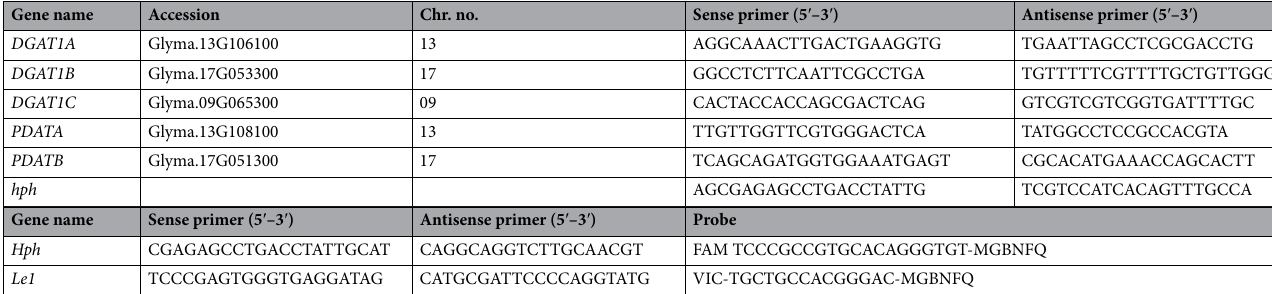
Table 2. Sets of qPCR (quantitative polymerase chain reaction) and PCR primers used to amplify genes specific regions and the sequences of primers and probes used for copy number assay.